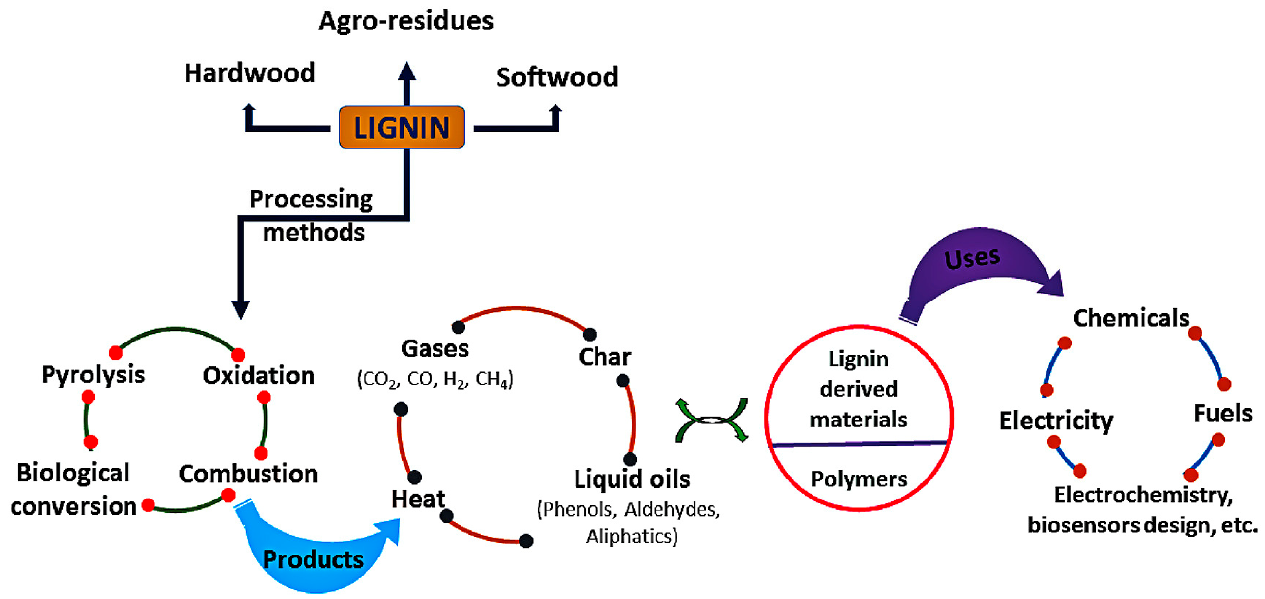
Figure 2. Lignin-based circular economy [17].